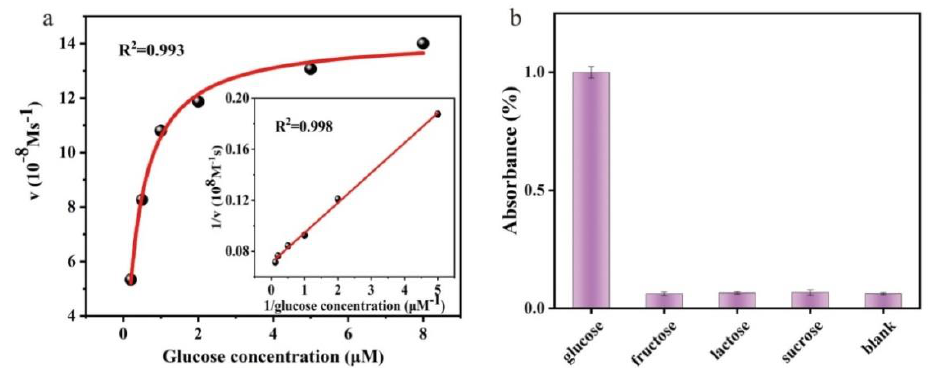
Figure 3. Response range of catalytic glucose with GOx@GA − Fe (ii) ( a ) Selectivity for glucose detection by monitoring the relative activity and ( b ). The error bars represent the standard deviation of three measurements.